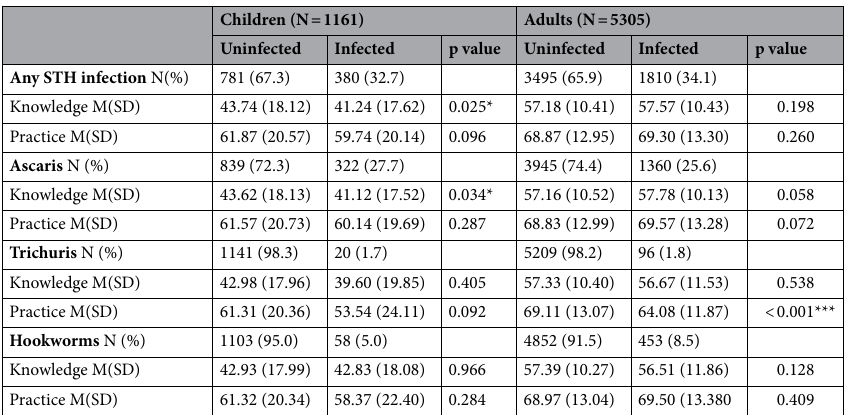
Table 3. Results of STH outcomes and comparisons of knowledge and practice scores between infected and uninfected groups. Notes: 1. Mann–Whitney U tests were performed to compare the differences in knowledge and practice scores (in percentage between uninfected and infected groups; 2. Significance levels: *p < 0.05, **p < 0.01, ***p < 0.001.